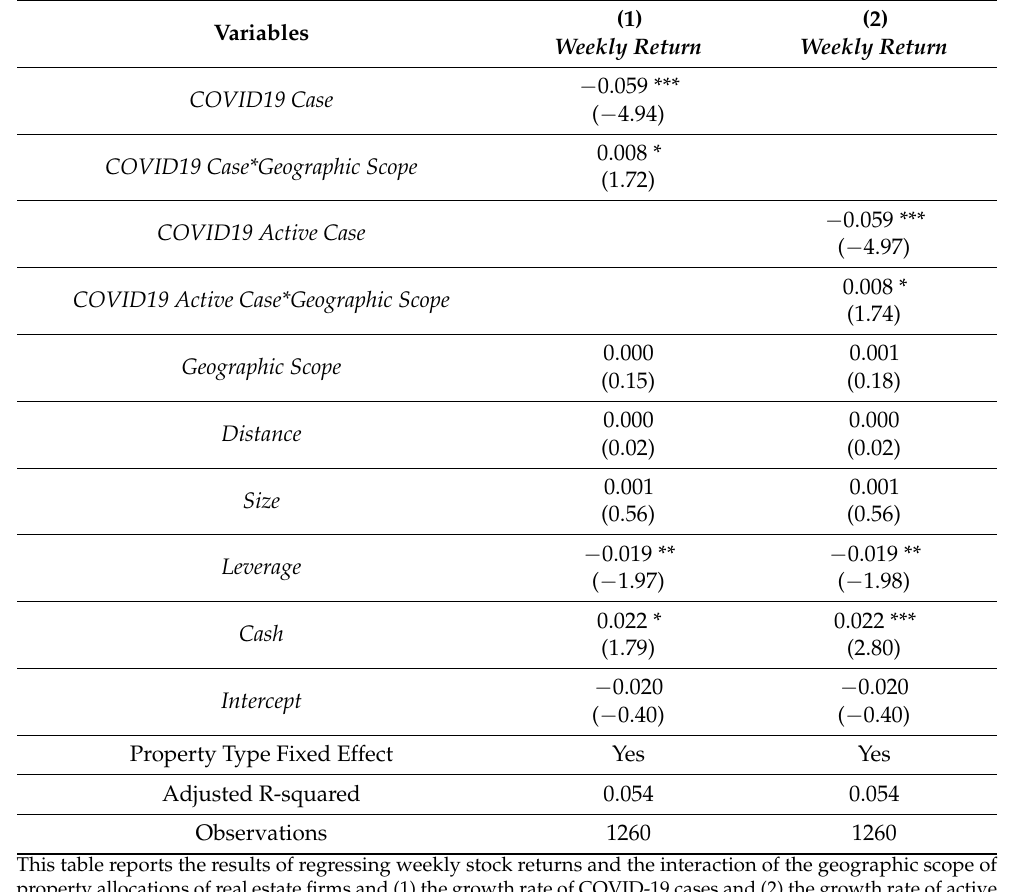
Table 3. Geographic scope and stock market returns during the COVID-19